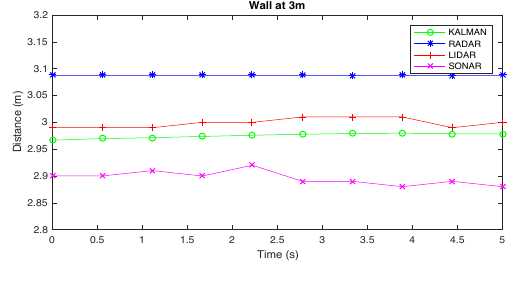
Figure 8. Wall at 3m distance